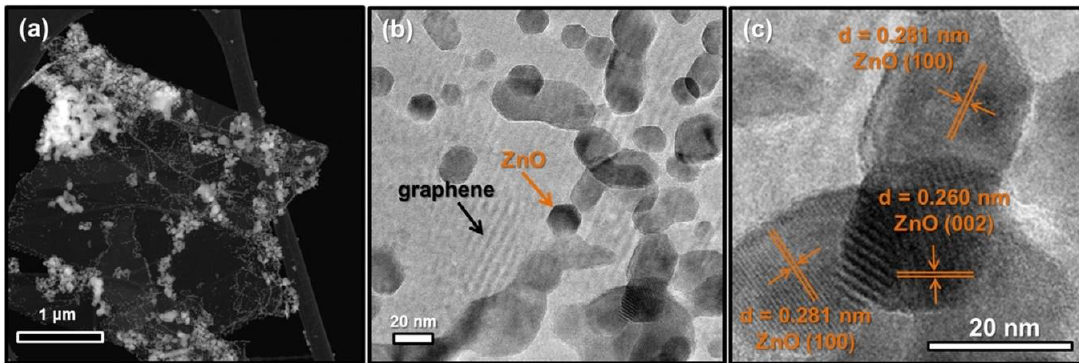
Figure 82. TEM images of ( a – c ) ZnO NPs / graphene nanocomposites. Products synthesised by the microwave sintering process. Reprinted from [927], Copyright (2017), with permission from Elsevier [OR APPLICABLE SOCIETY COPYRIGHT OWNER]. All rights reserved. In order to re-use permission must be obtained from the rightsholder.